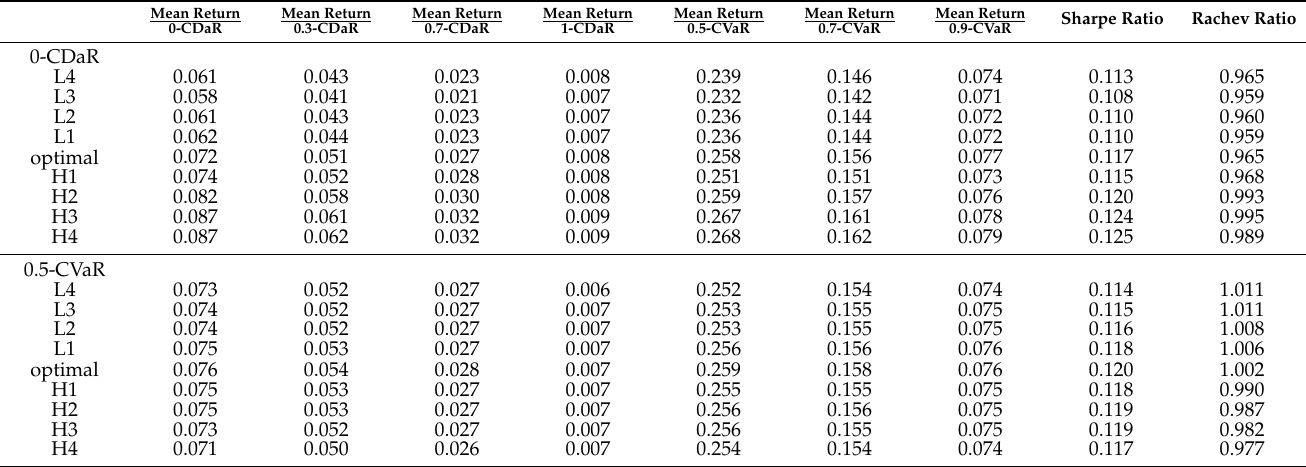
Table 5. Performance ratios of suboptimal portfolios with different risk